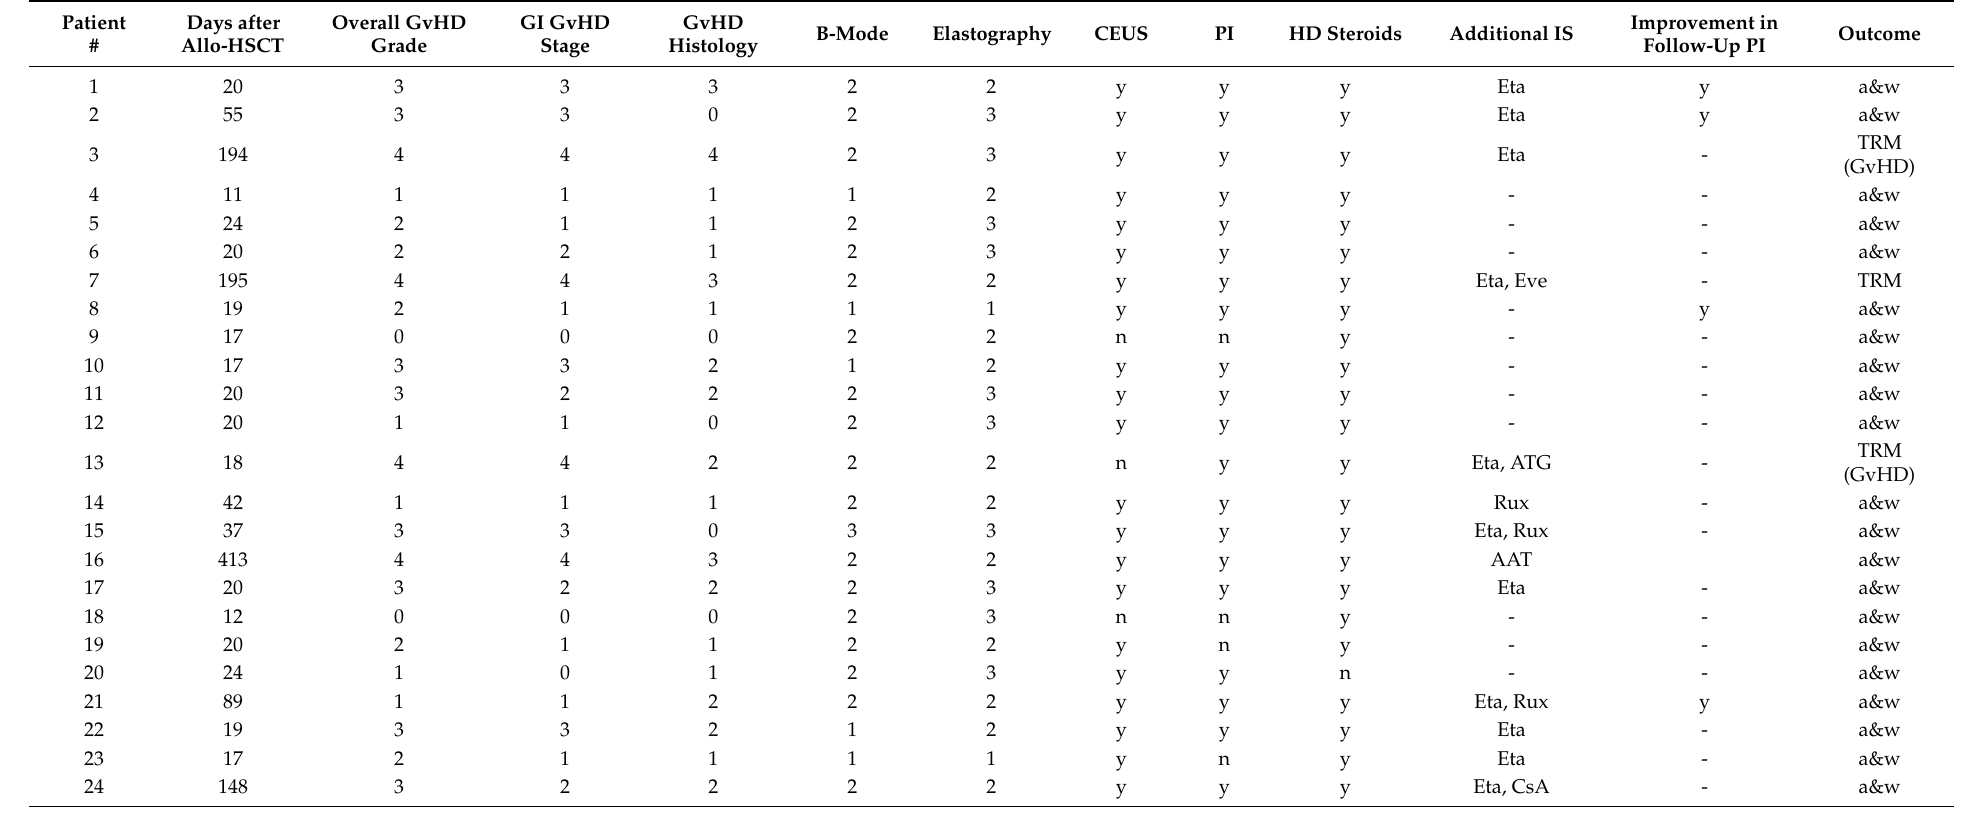
Table 2. Diagnostic findings and clinical outcome of patients with